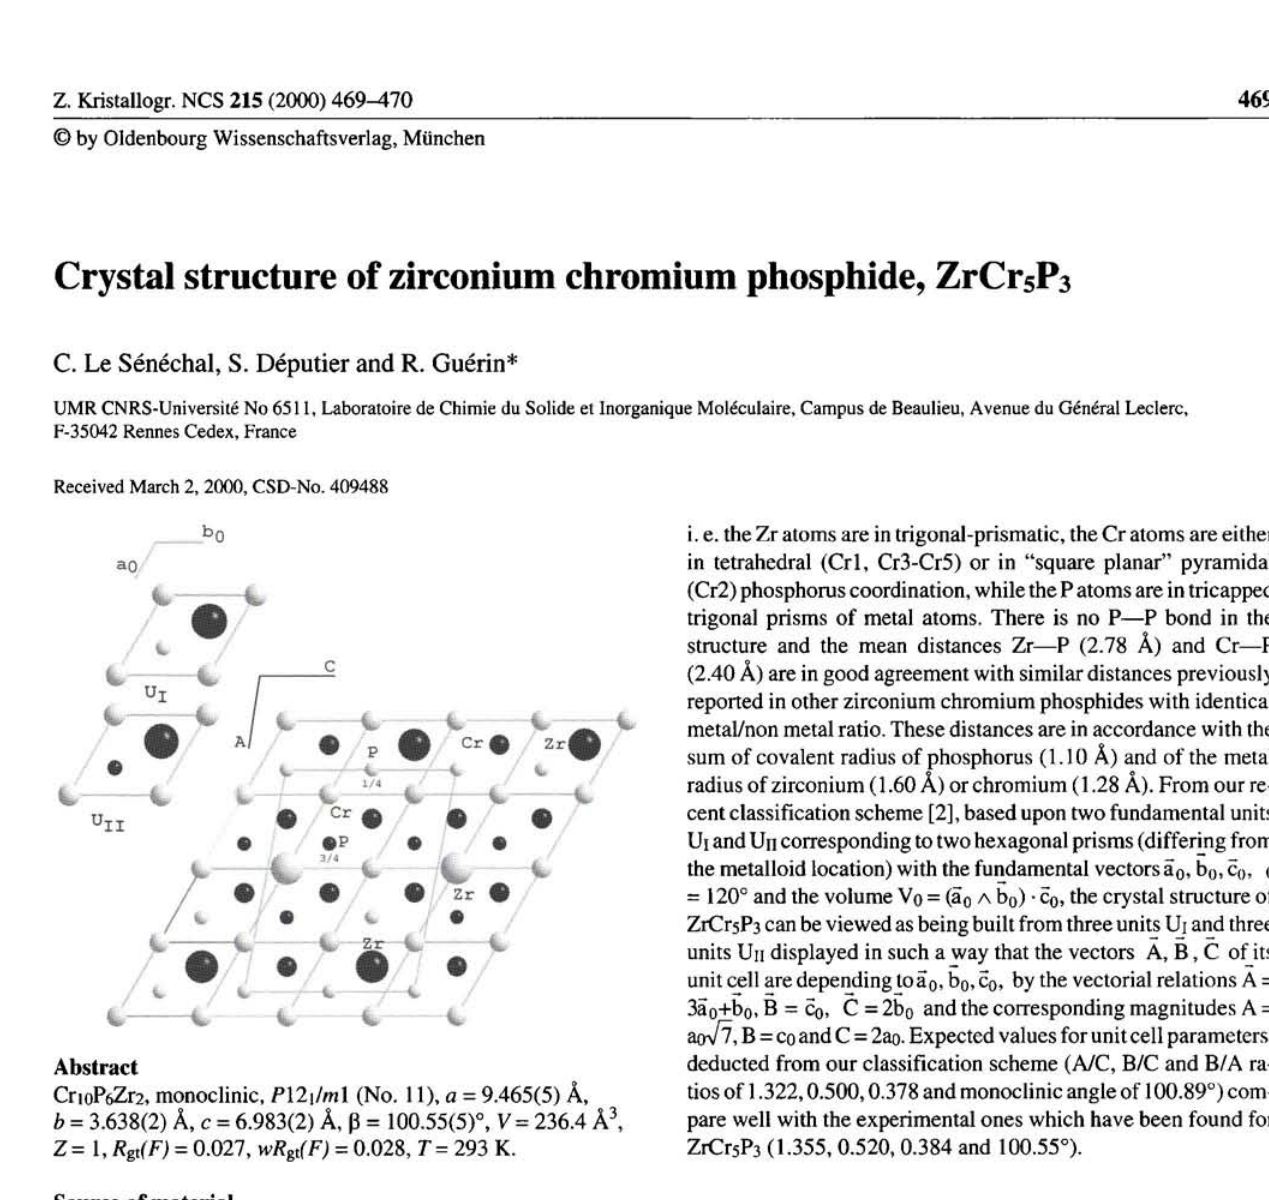
Table 2, Atomic coordinates and displacement parameters (in Â 2 ).